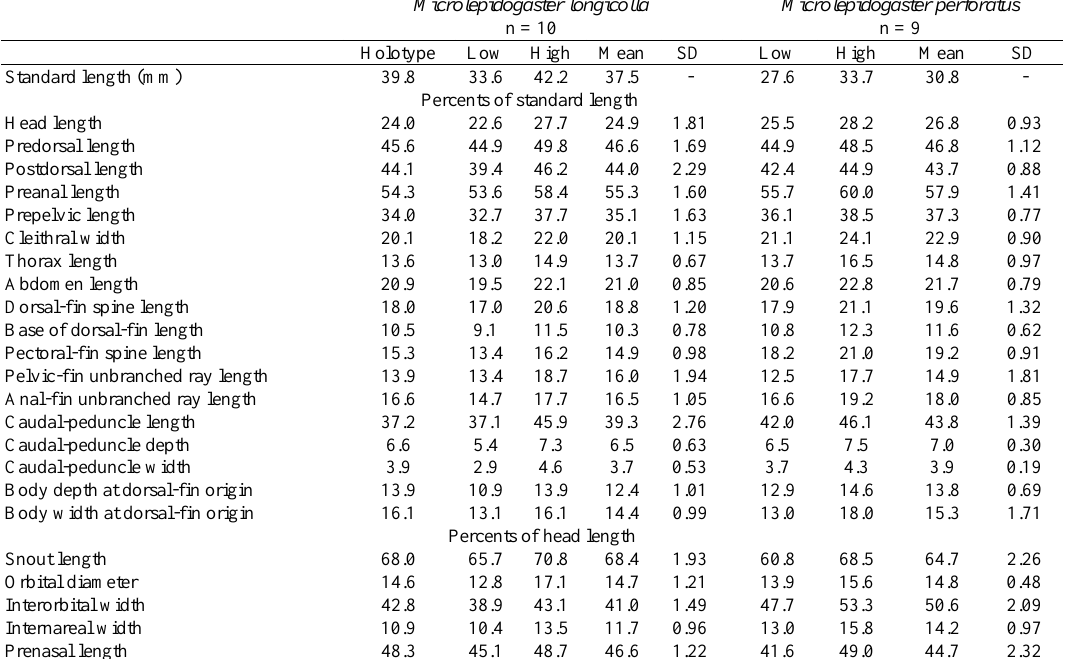
Table 1. Morphometrics of species of Microlepidogaster. Values are given for holotype and nine paratypes of M . longicolla . SD = Standard deviation.